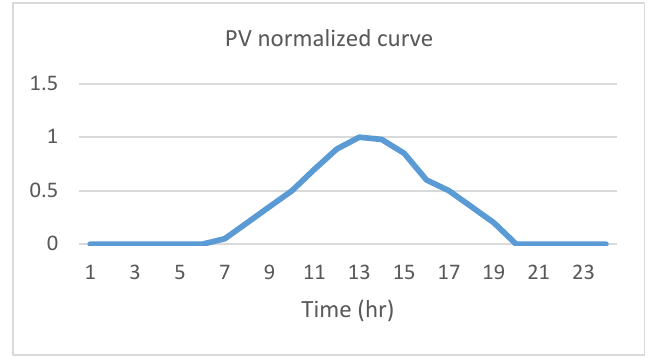
Table 4. Characteristic of the chosen elements.